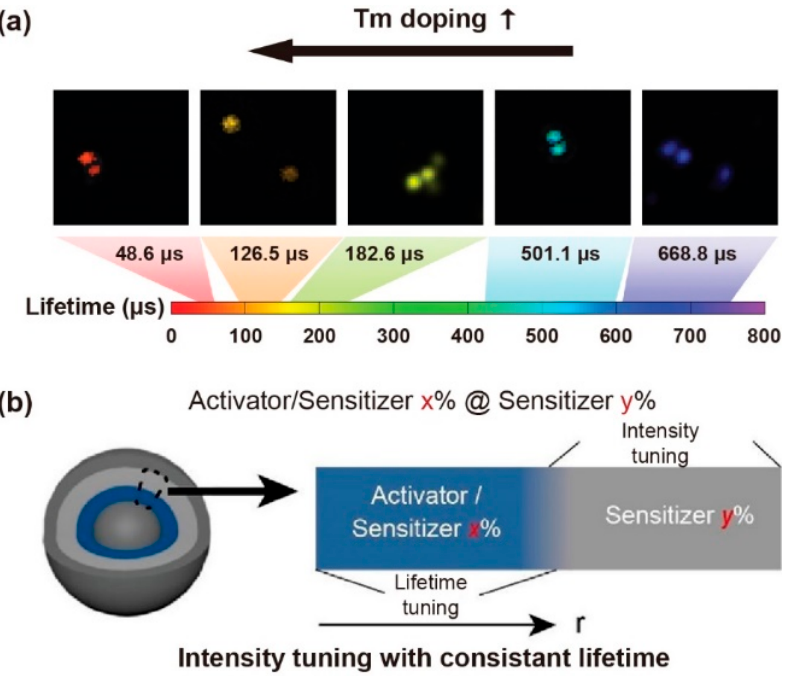
Figure 3. ( a ) The time-resolved confocal images of NaYF 4 : Yb,Tm nanoparticles and the lifetime tuning scheme by changing Tm 3+ doping concentrations. Reproduced with permission from